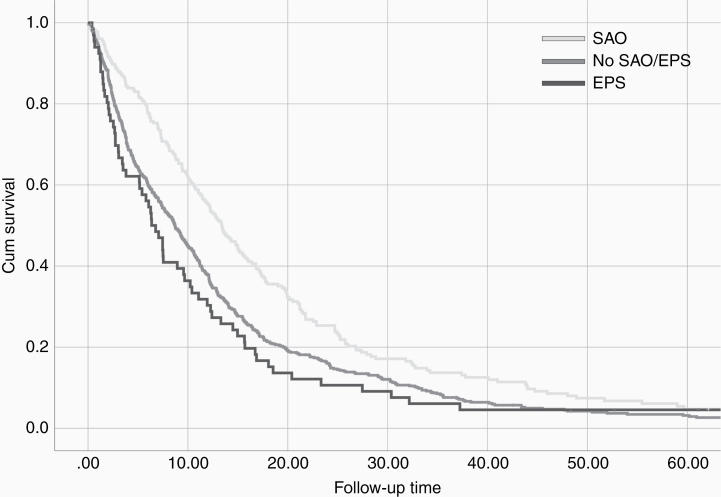
Kaplan–Meier survival plot showing the survival differences between the patients with SAO, EPS, and no perioperative seizures (no SAO and no EPS).